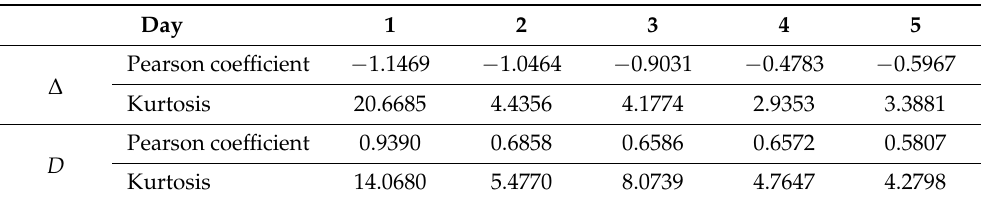
Table 3. Pearson coefficients and kurtosis values of the statistical data distributions of the wound healing